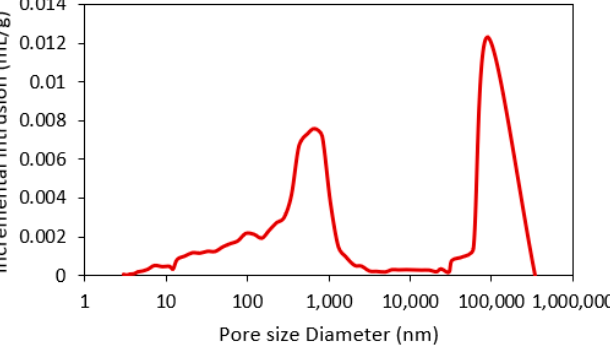
Figure 8. Pore size distribution of tested siltstone.